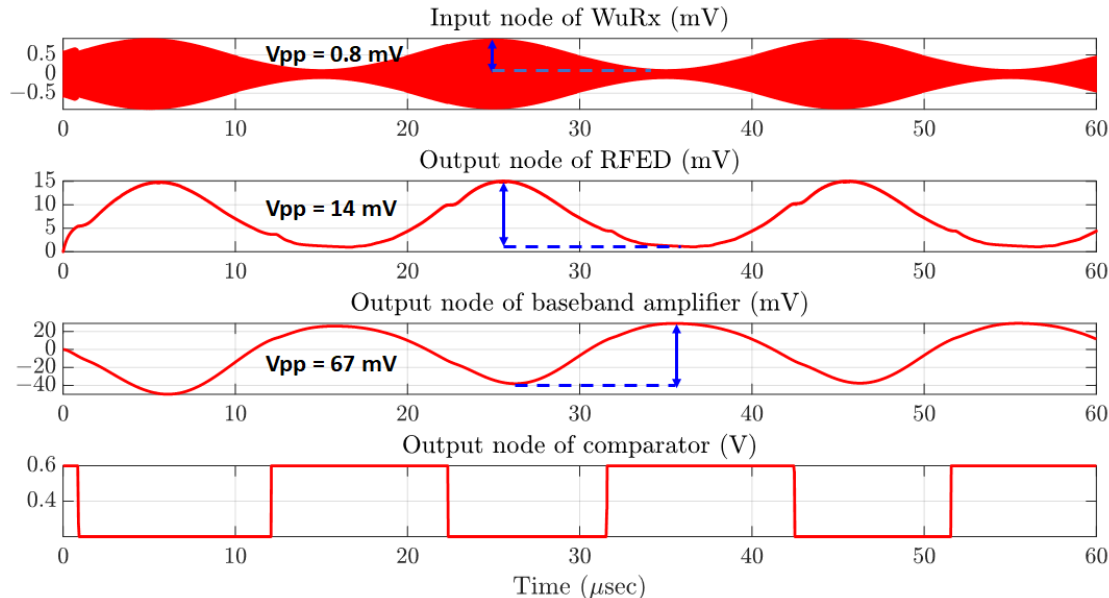
Figure 11. Post layout simulated voltage waveforms of input node of WuRx and output node of RFED, baseband amplifier, and comparator.